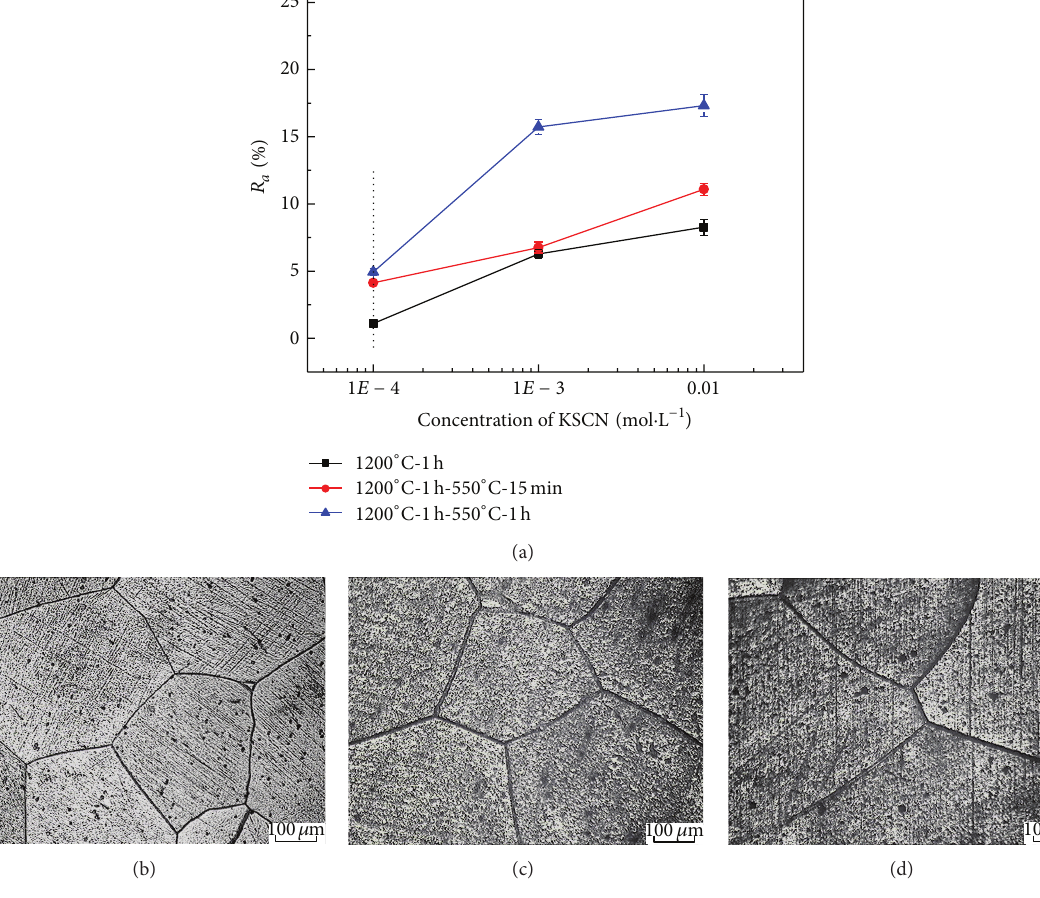
Figure 2: Effect of KSCN concentration in the DL-EPR test. (a) Influence on 𝑅 𝑎 values (𝑑𝐸/𝑑𝑡 = 100 mV/min and 𝑇 = 30 ∘ C); (b)–(d) micrographs of FSS 429 aging at 550 ∘ C for 15min after test, (b) 0.0001 M KSCN, (c) 0.001M KSCN, and (d) 0.01 M